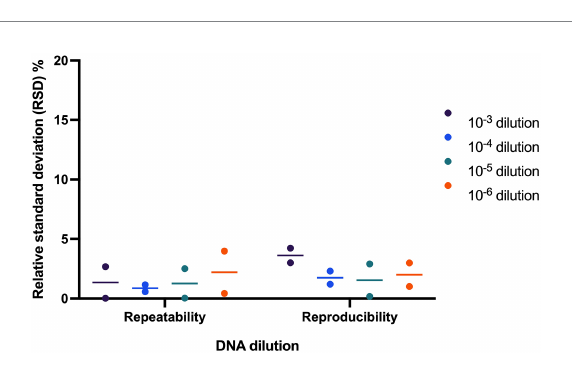
FIGURE 4 Evaluating precision of L. paracasei 8700:2 strain-specific quantitative assay. Two samples were tested at four dilutions to determine assay precision. The relative standard deviation (RSD%) ranged from 0.02 to 3.99% and from 0.18 to 4.23% for repeatability and reproducibility,